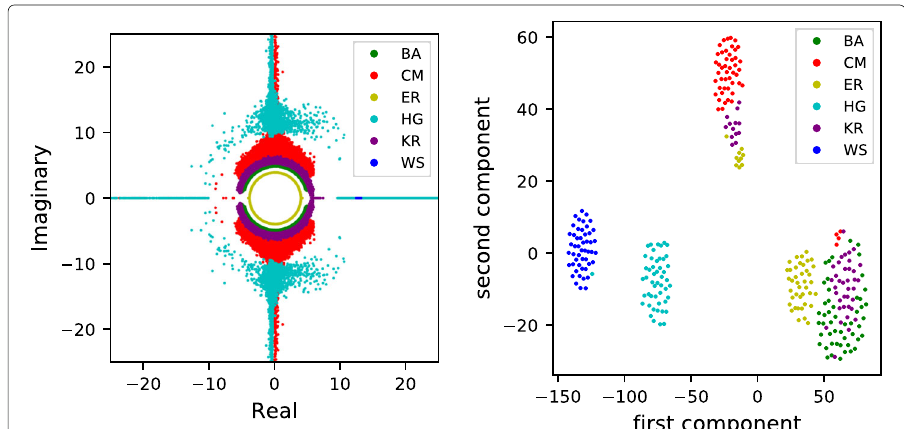
Fig. 1 Non-backtracking eigenvalues of random graphs. Left: From six different random graph models – Erdös-Rényi (ER), Barabási-Albert (BA), Stochastic Kronecker Graphs (KR), Configuration Model with power law degree distribution (CM), Watts-Strogatz (WS), Hyperbolic Graphs (HG) – we generate 50 graphs. From each of those 300 ( = 6 × 50) graphs, we plot the largest r = 200 non-backtracking eigenvalues on the complex plane. To make the plot more readable, we show only eigenvalues close to the origin. All graphs have n = 5 × 10 4 nodes and average degree approximately (cid:2) k (cid:3) = 15. Right: For each graph used in the left